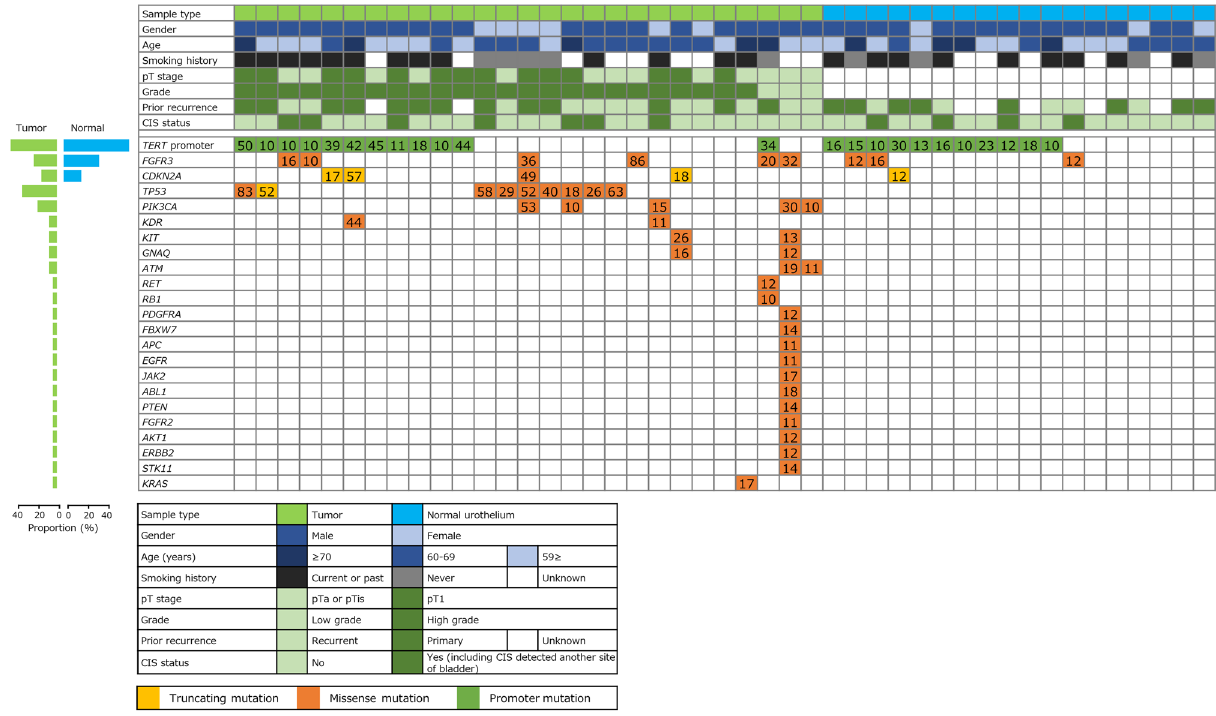
Figure 1. Somatic mutation landscape of tumor and normal samples from patients with NMIBC. Clinical information and clinical samples used in this study (top), and the type of mutation and variant allele frequency (bottom) were shown in this landscape. The proportion mutations in both tumor and normal specimens were shown in left.